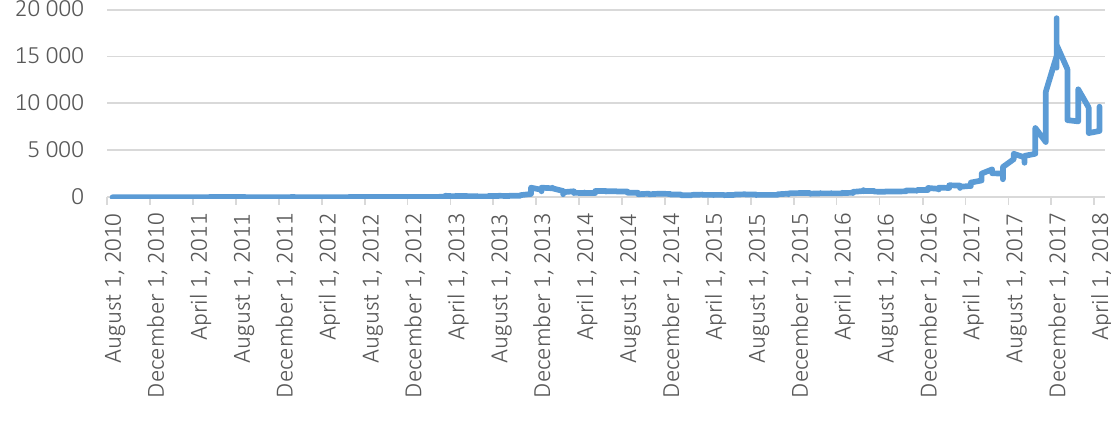
Figure 1. The market value for Bitcoin for the sample